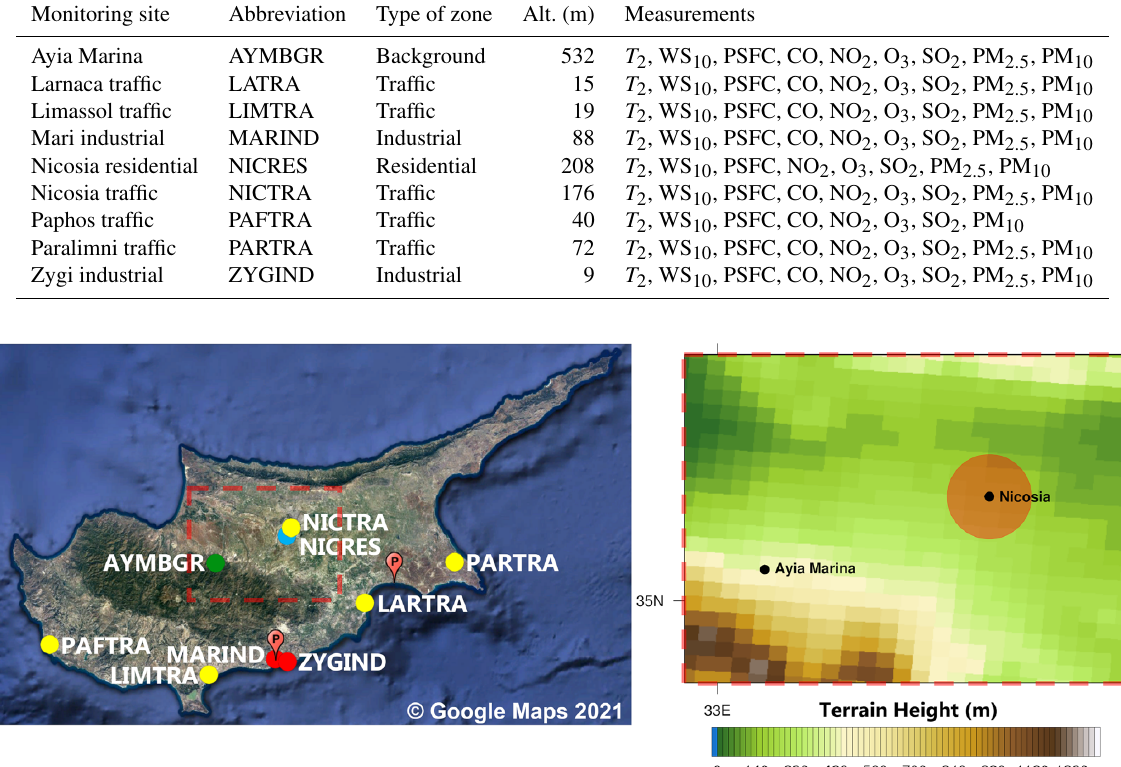
Figure 2. Left panel: air quality monitoring stations locations (from © Google Maps). The the two power-generation stations locations are also shown across the south coastline of Cyprus. Right panel: terrain elevation and the locations of the Ayia Marina background station and the city of Nicosia. The red circle indicates the urban area limits.